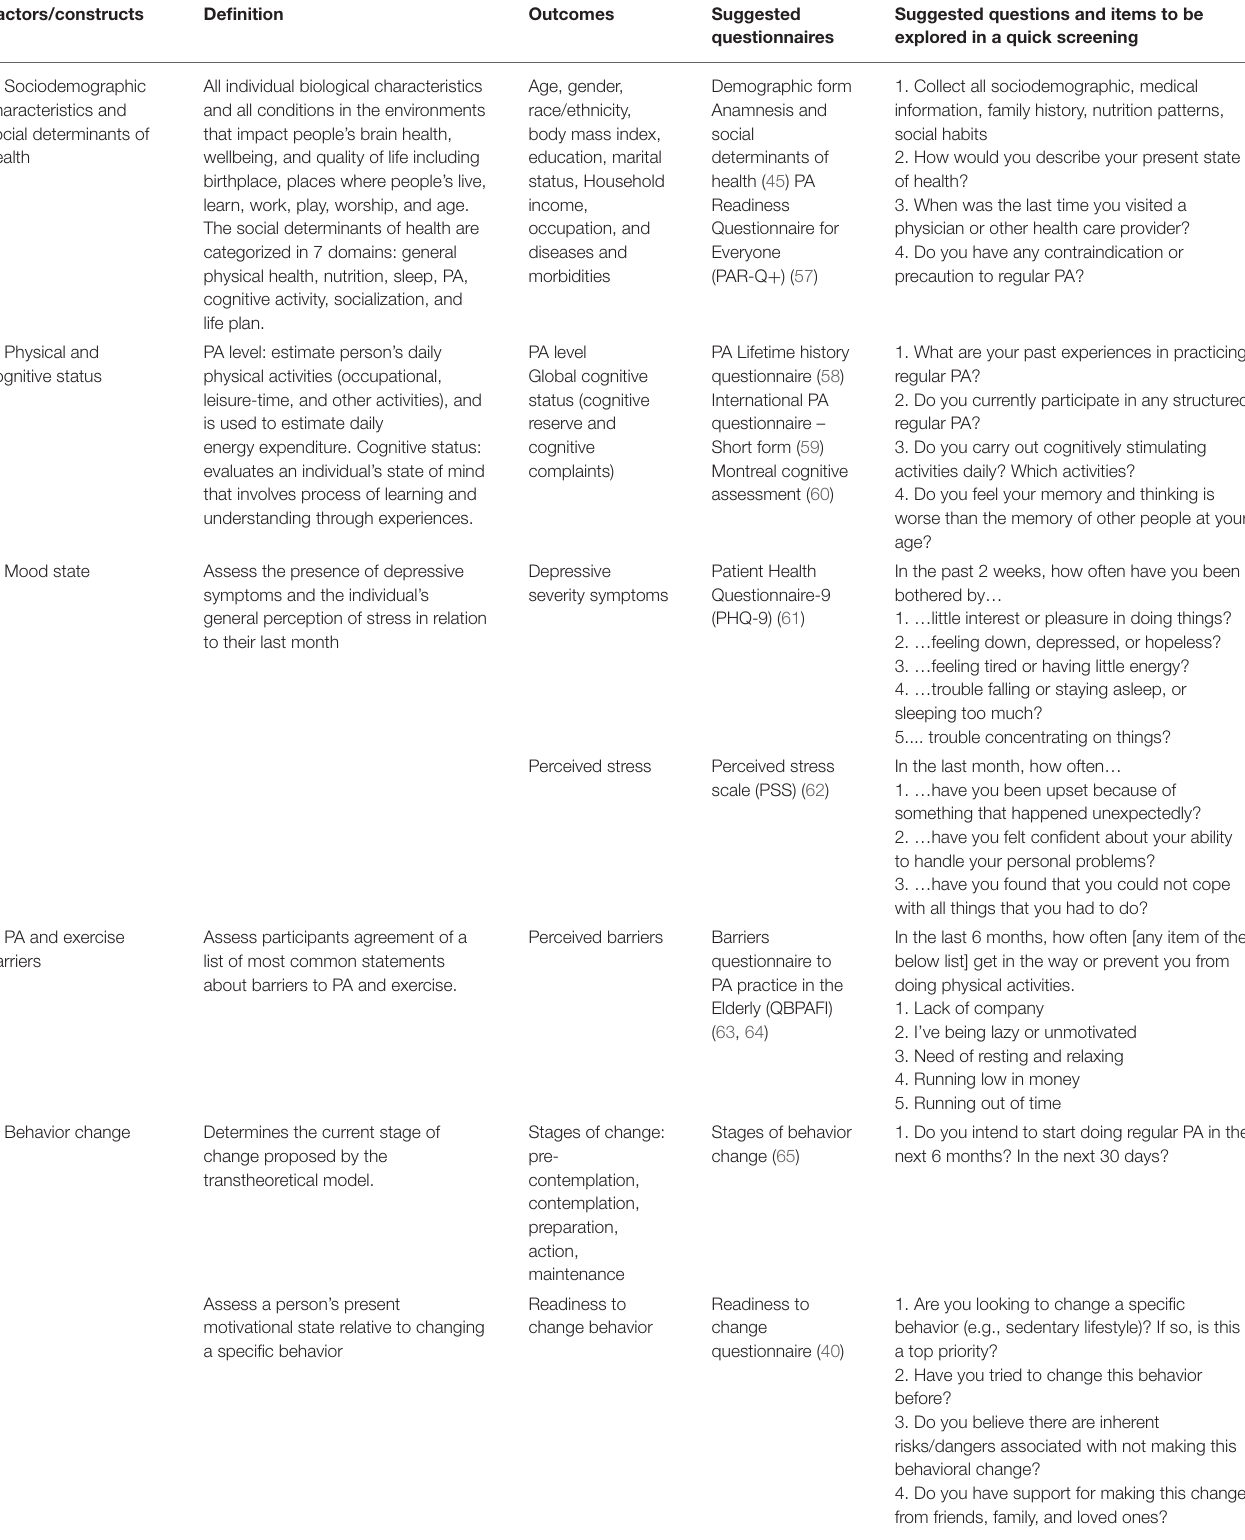
TABLE 1 | Toolkit summary and key components for a quick assessment of physical activity adherence-related factors.